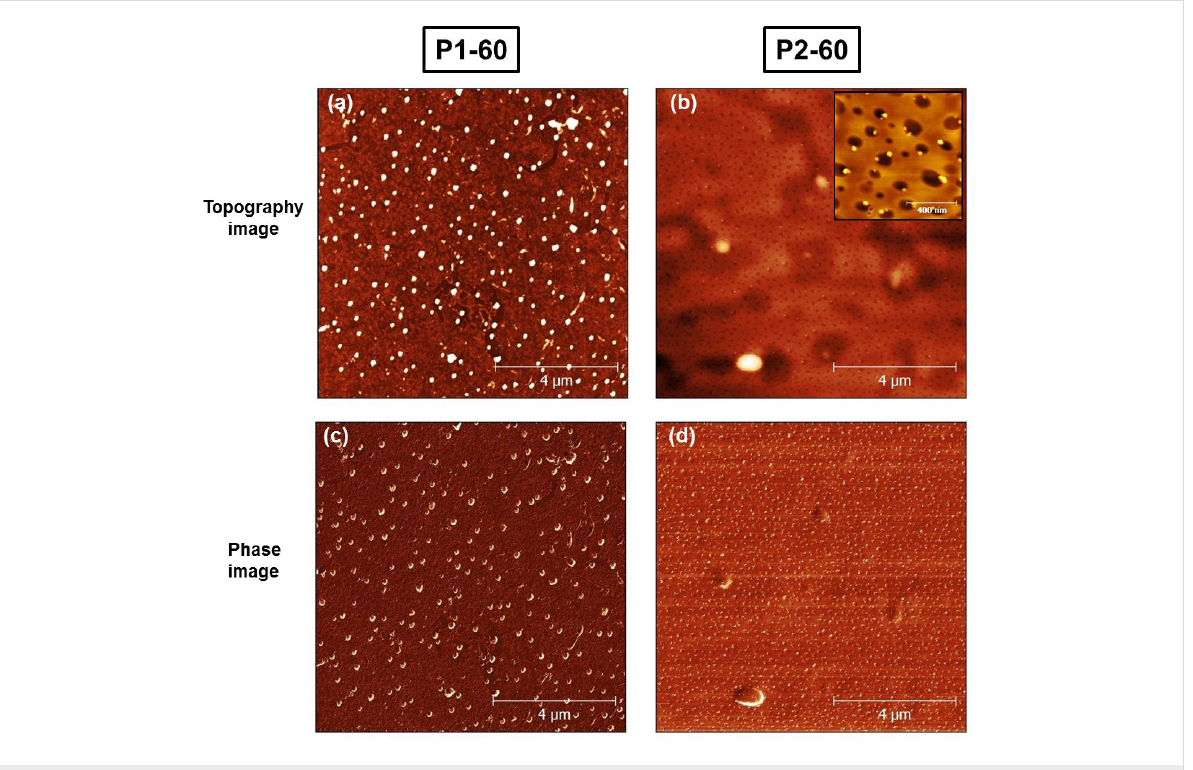
Figure 3: (a,b) AFM topography and (c,d) phase images of 60% Au–PMMA nanocomposites with low M w (P1-60) and high M w (P2-60). Inset in (b) shows a magnified AFM image for the